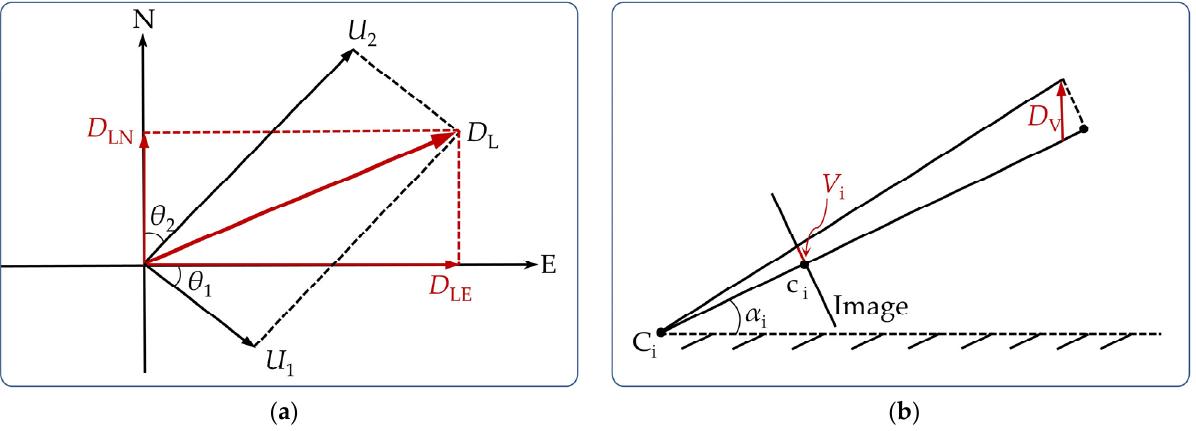
Figure 2. Schematics for computing displacement: ( a ) lateral displacement; ( b ) vertical settlement. The relationships between the lateral displacement and vertical settlement, and the measured displacement components of T 1 and T 2 are shown in Figure 2. Let θ 1 be the angle between U 1 and E-axis, and θ 2 be the angle between U 2 and N-axis. According to the Figure 2a, the lateral displacement, D L , can be computed as: